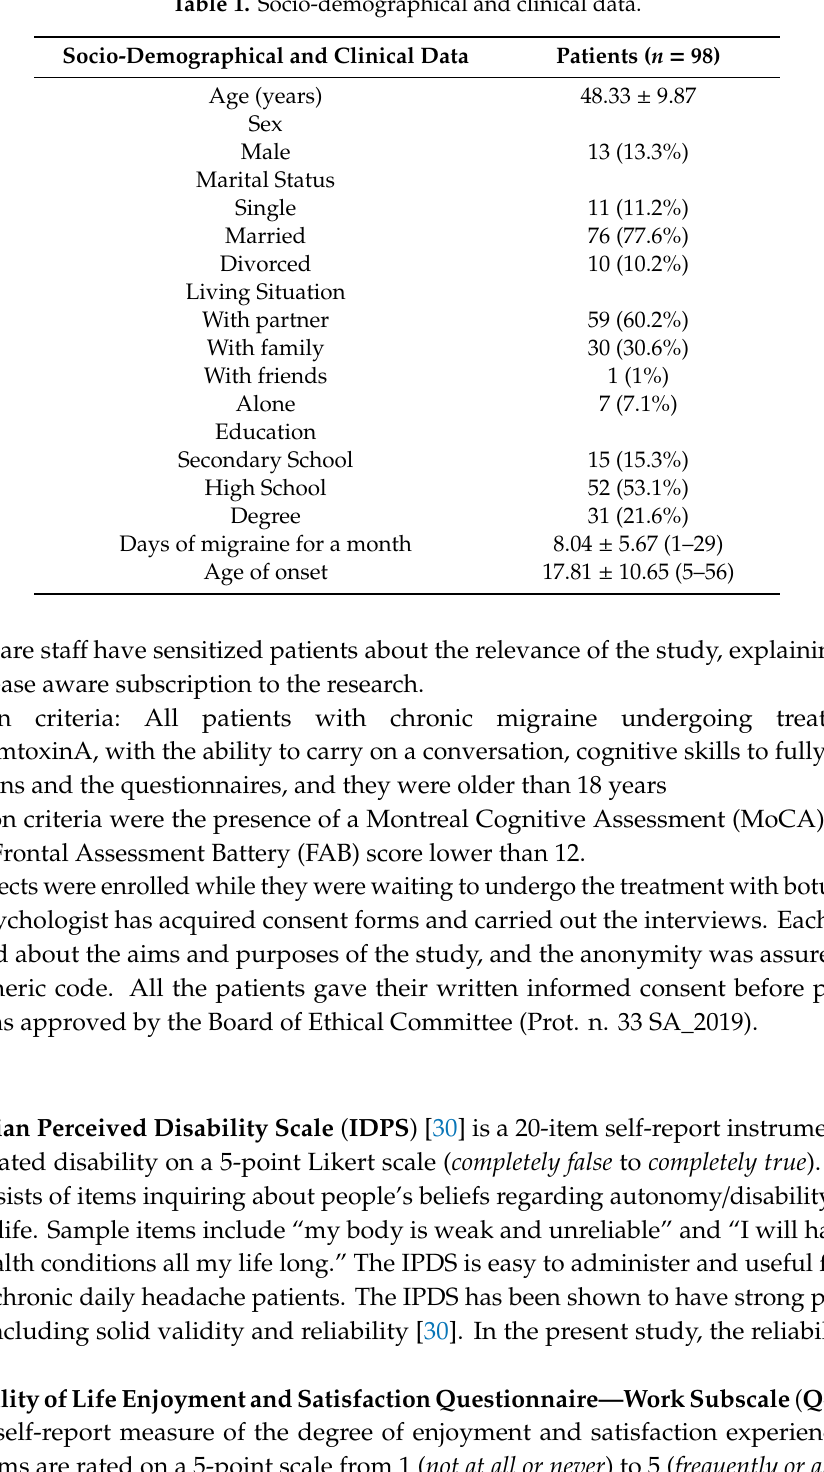
Table 1. Socio-demographical and clinical